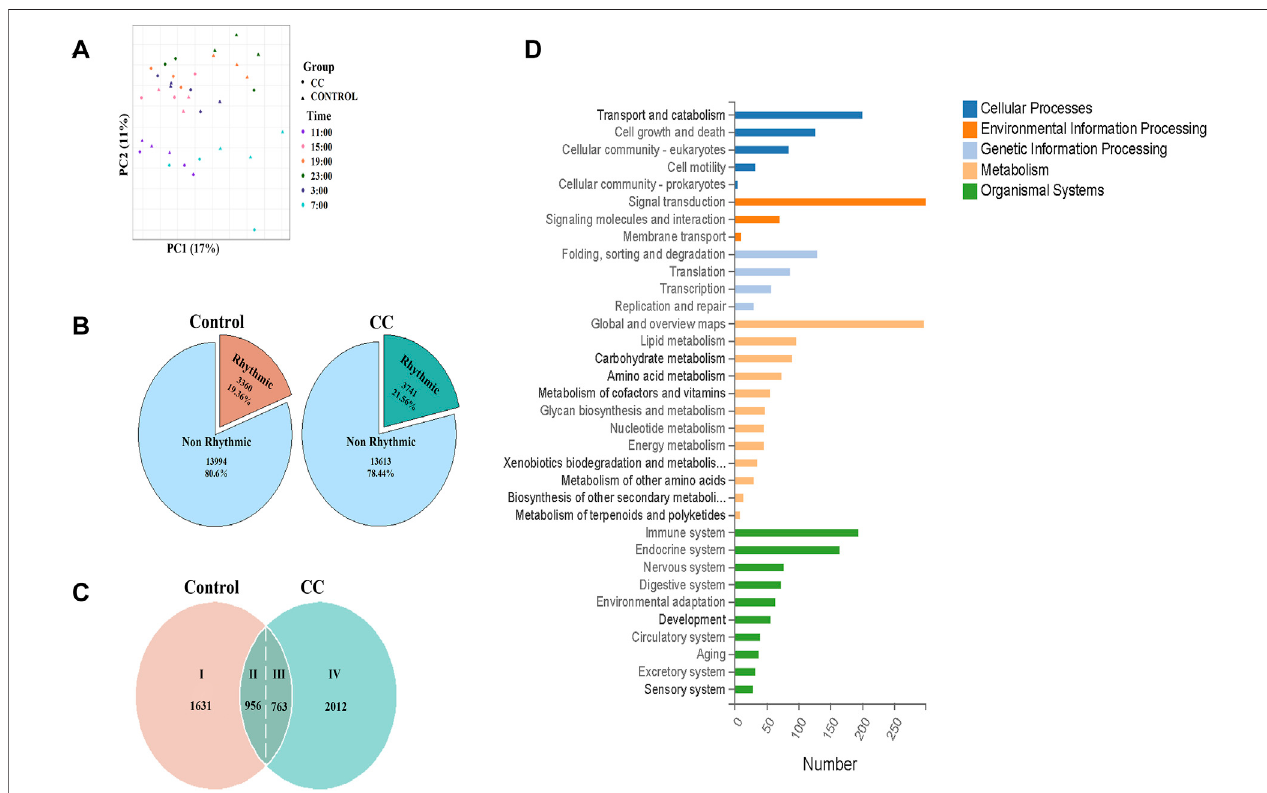
FIGURE 3 | Chronic cold exposure alters the circadian rhythm of transcriptional gene expression in the liver. (A) Principal component analysis (PCA) of samples based on liver genes, with color indicating sampling time. The circle indicates the control group, and the triangle indicates the chronic cold (CC) group. (B) Pie chart of chroniccold(CC)transcriptomecompositionforthecontrolgroup. (C) Rhythmictranscriptomewasclassi fi edbasedontheexpressionpatternofeachgeneundereach environmentandgenotype — thepiechartillustratingthedistributionofgenesintheliverbycategory. (D) KEGGfunctionalannotationbarchartdepictsthefunction of 2775 genes classi fi ed as category Ⅲ and Ⅳ